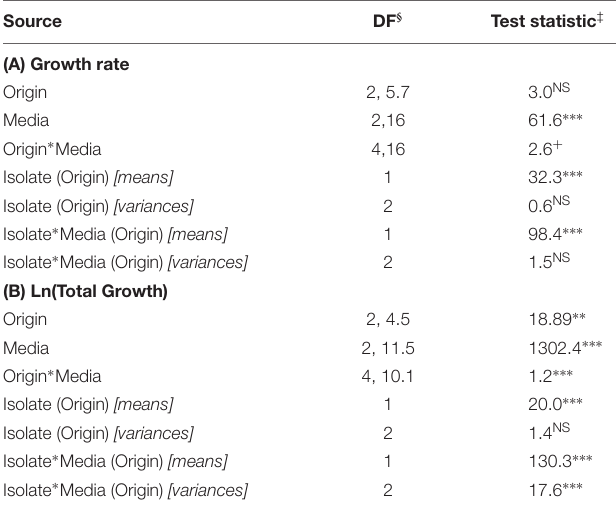
TABLE 2 | Dependence of P. aeruginosa populations’ growth rate (A) and ln-transformed total growth achieved (B) on the fixed factors habitat of origin, assay media and their interaction, and the random factors isolate and the interaction of isolate with assay media, as determined using mixed linear